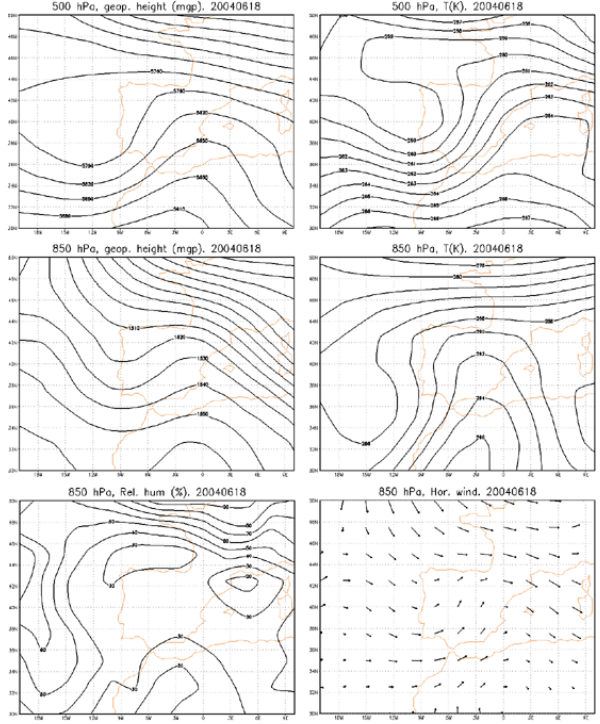
Fig. 6. NCEP reanalysis, 12:00UTC. Date: 18 June 2004, CL2. The atmospheric fields shown are: φ 500 (gpm), T 500 (K), φ 850 (gpm), T 850 (K), rh 850 (%) and wind direction at 850hPa, from left to